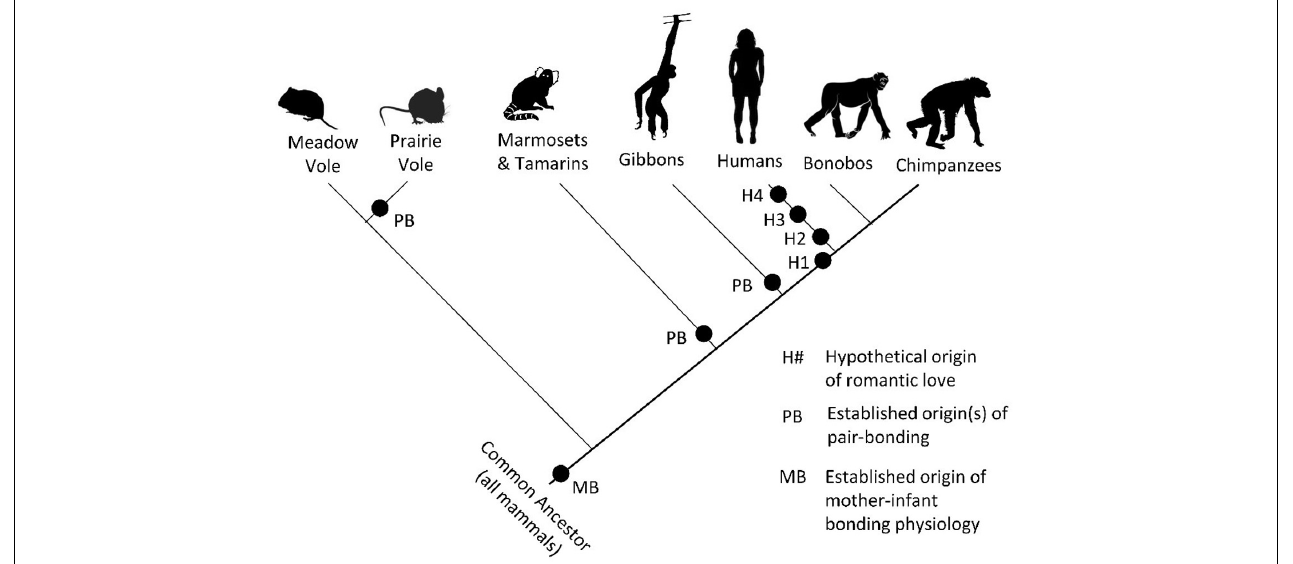
FIGURE 1 | Phylogenetic relationships among select mammal species that